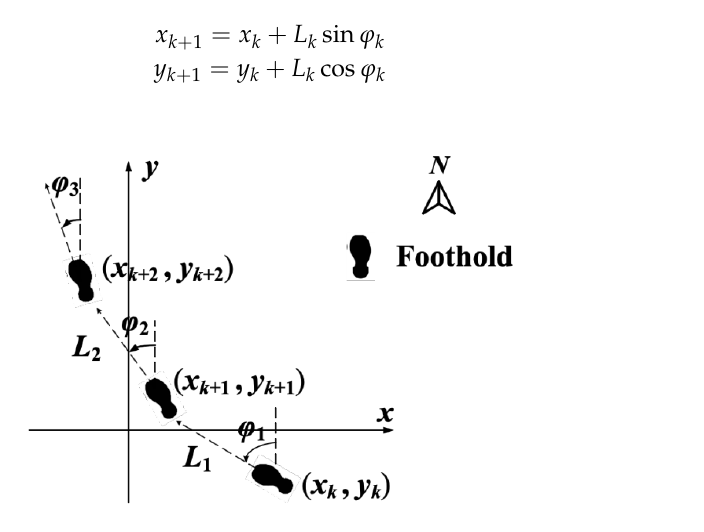
Figure 1. Pedestrian dead reckoning model.